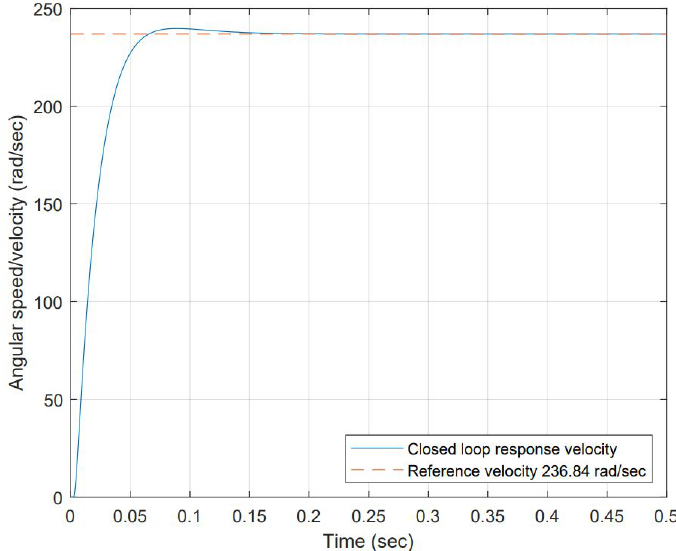
Figure 8. System response to a 9 volts step input in a closed-loop configuration. The system exhibits an under-damped response achieving 63% of reference angular velocity at 0.025 s. This is consistent with experimental open-loop data. The steady estate 0% error is achieved at 0.2 s at approximately 240